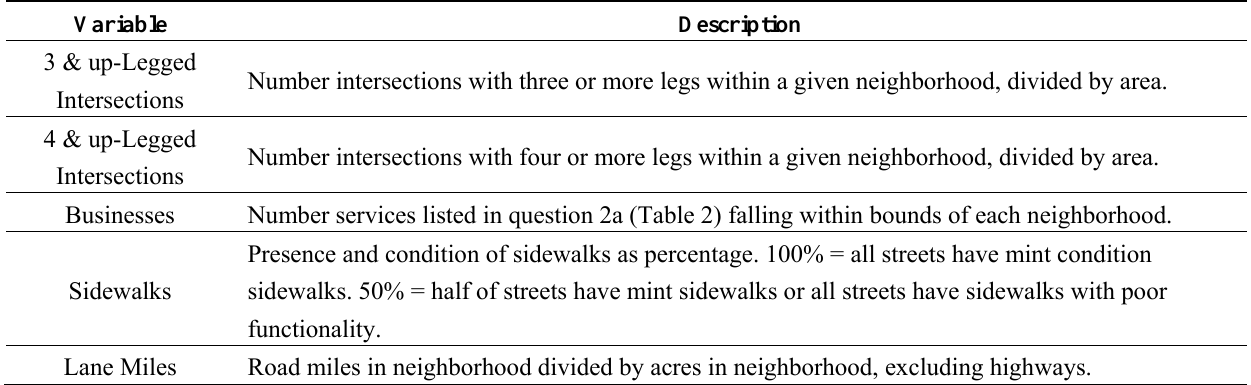
Table 5. Explanatory variables: built